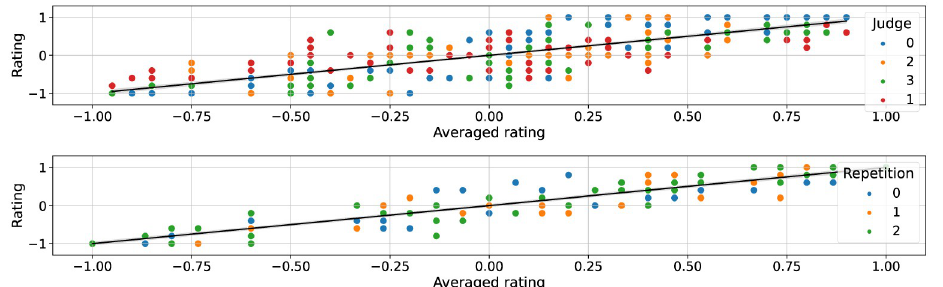
Fig 3. Distribution of ratings against their averaged value for dataset D inter (top) and D intra (bottom). The distribution around the averaged value is representative of the annotation noise, which appears greater for different raters as compared to different annotation session for the same rater, as reflected by comparing the ICC values of D and D intra